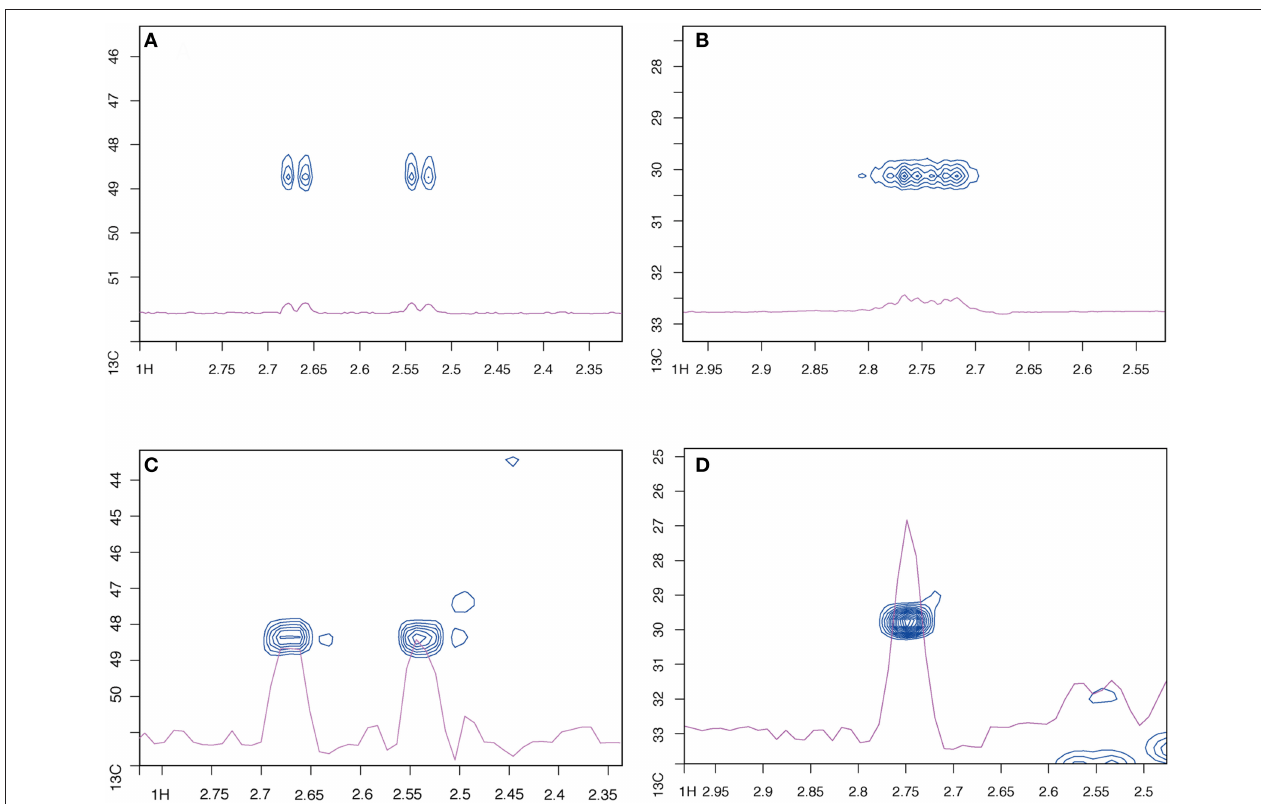
FIGURE 1 | The constant-time HSQC has better peak shape for fully 13 C labeled C. elegans extracts than the standard sequence. (A,B) Show two selected peaks using a standard HSQC, (C,D) show the same peaks, respectively, with the ct-HSQC.